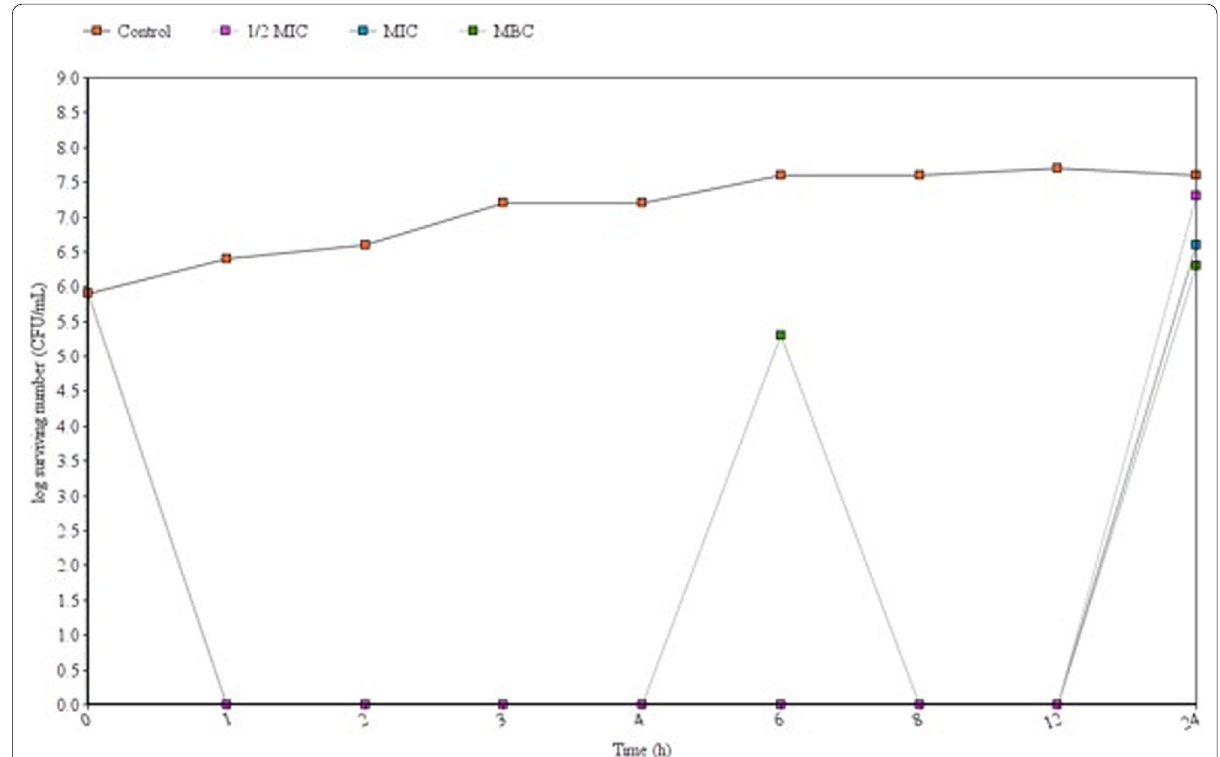
Fig. 1 Bactericidal kinetic of ESBL -E. coli (ECB132) exposed to EOSA. The concentrations were: 1/2 MIC: 5 mg/mL; MIC: 10 mg/mL; MBC: 80 mg/mL. CFU: colony‑forming unit; hours (h); control (chloramphenicol); MIC: minimum inhibitory concentration; MBC: minimum bactericidal concentration. For kinetic curve the times measured were 0, 2, 4, 6, 8, 12 h with a decrease of bacteria except for MBC at 6 h until 24 h an increasing of bacteria survival in comparison with control